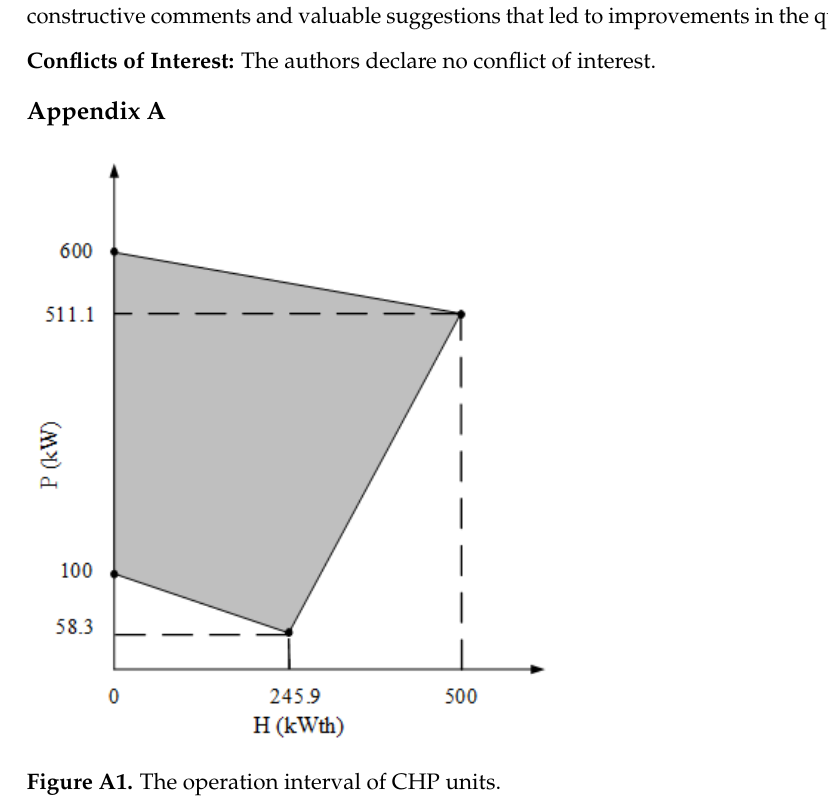
Figure A1. The operation interval of CHP units. Table A1. Device parameters.